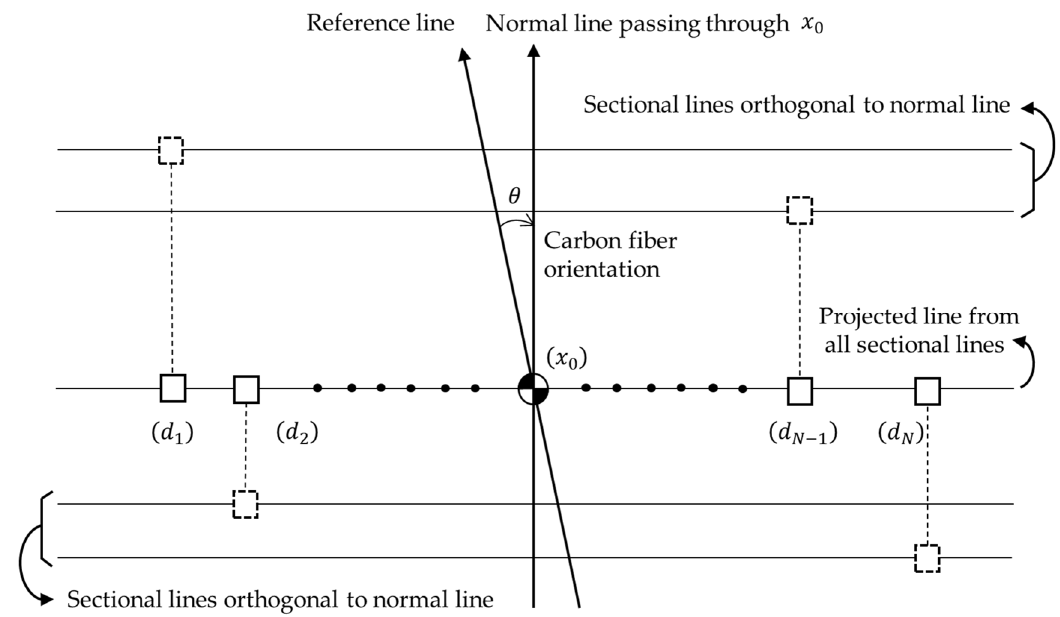
Figure 1. Configuration of the projected line from all sectional lines of the UCBC structure with carbon fiber orientation 𝜃 ; : measured, : projected.